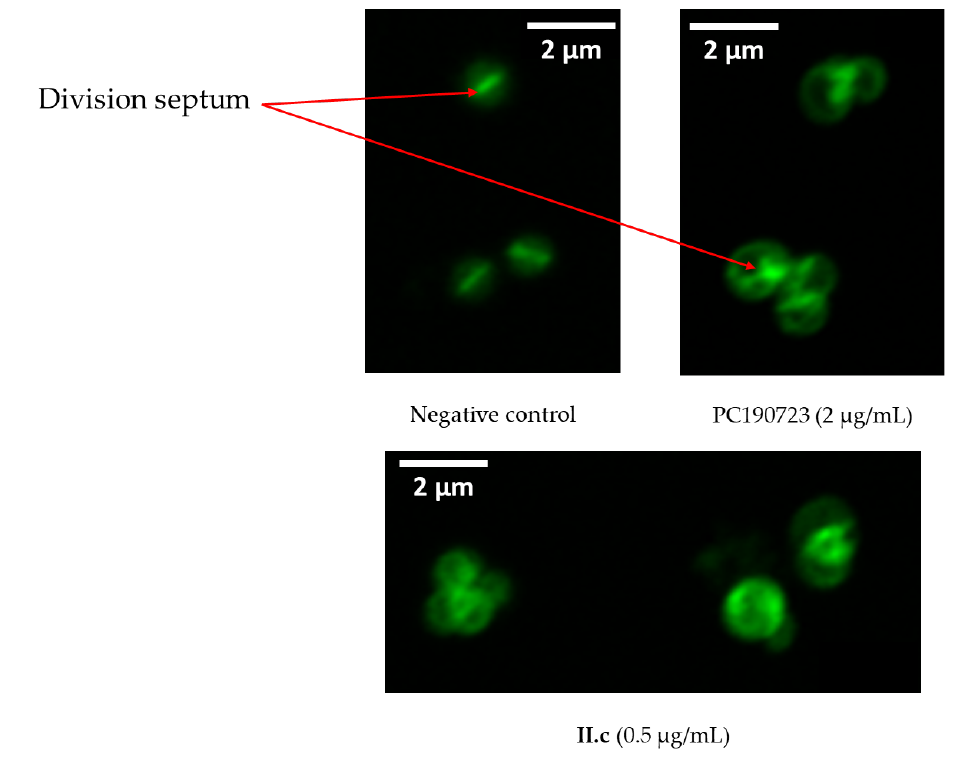
Figure 3. Fluorescence microscope images of ATCC 29213 bacteria stained with vancomycin-bodipy